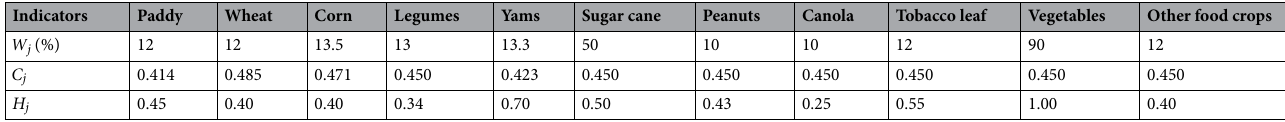
Table 2. Water content, carbon uptake and economic coefficients for economic yield of major crops.